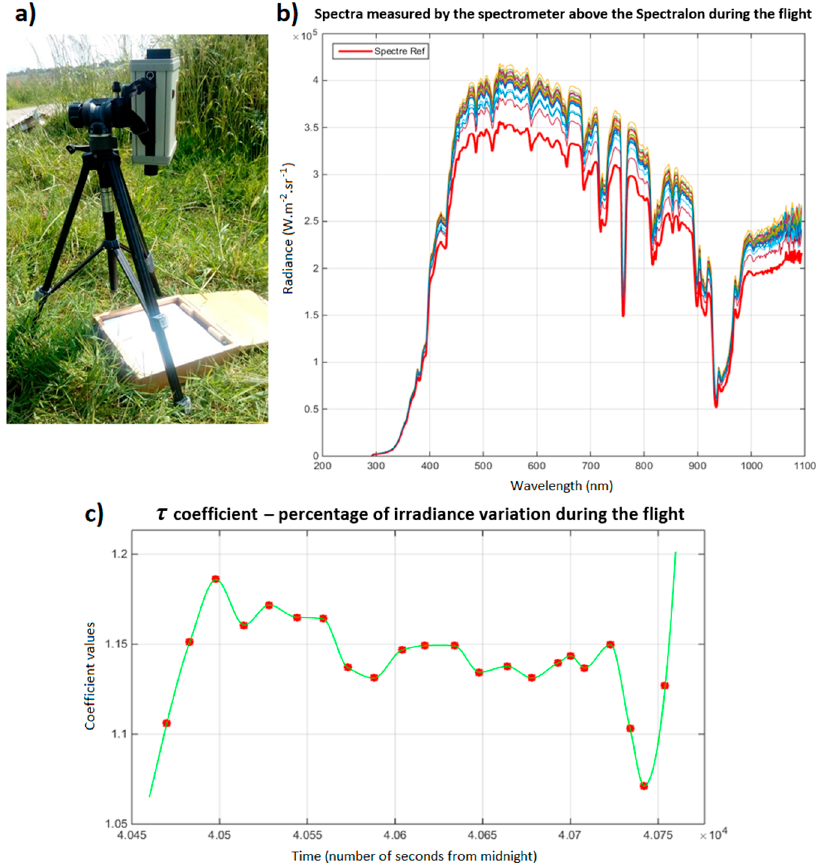
Figure 5. ( a ) Field spectrometer (GER 1500) measuring the irradiance variability above the white Spectralon. ( b ) Example of variability of the spectra measured by the field spectrometer during a flight. ( c ) Example of the τ coefficient interpolated (green line) from the percentage of irradiance variations measured (red dots) during the flight.